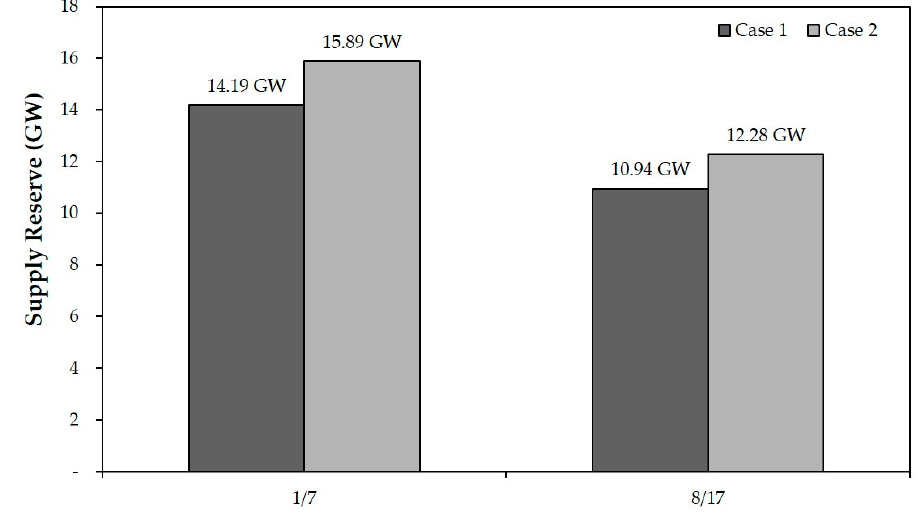
Figure 4. Change in the supply reserve according to reliability-based DR resources.